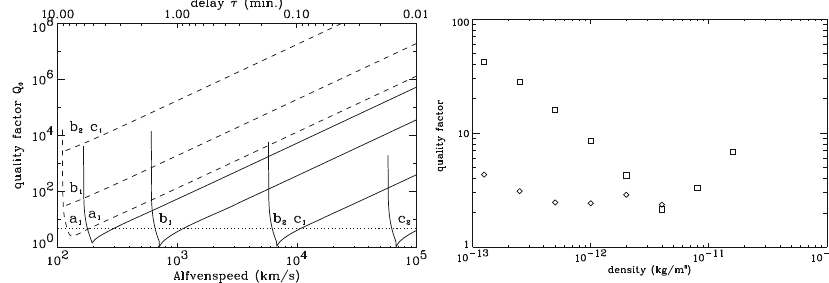
Fig. 83 Attenuation of prominence oscillations by wave leakage. a Quality factor ( Q 0 ≡ πτ d / P ) of stable IP (solid curves) and NP (dashed curves) prominence oscillations as a function of the coronal Alfvén speed. b Quality factor of the horizontally (squares) and vertically (diamonds) polarised stable oscillations versusthecoronaldensity.IPandNPrespectivelystandforinversepolarityandnormalpolarityprominence models. Images reproduced with permission from (left) Schutgens (1997b), copyright by ESO; and (right) from Schutgens and Tóth (1999), copyright by